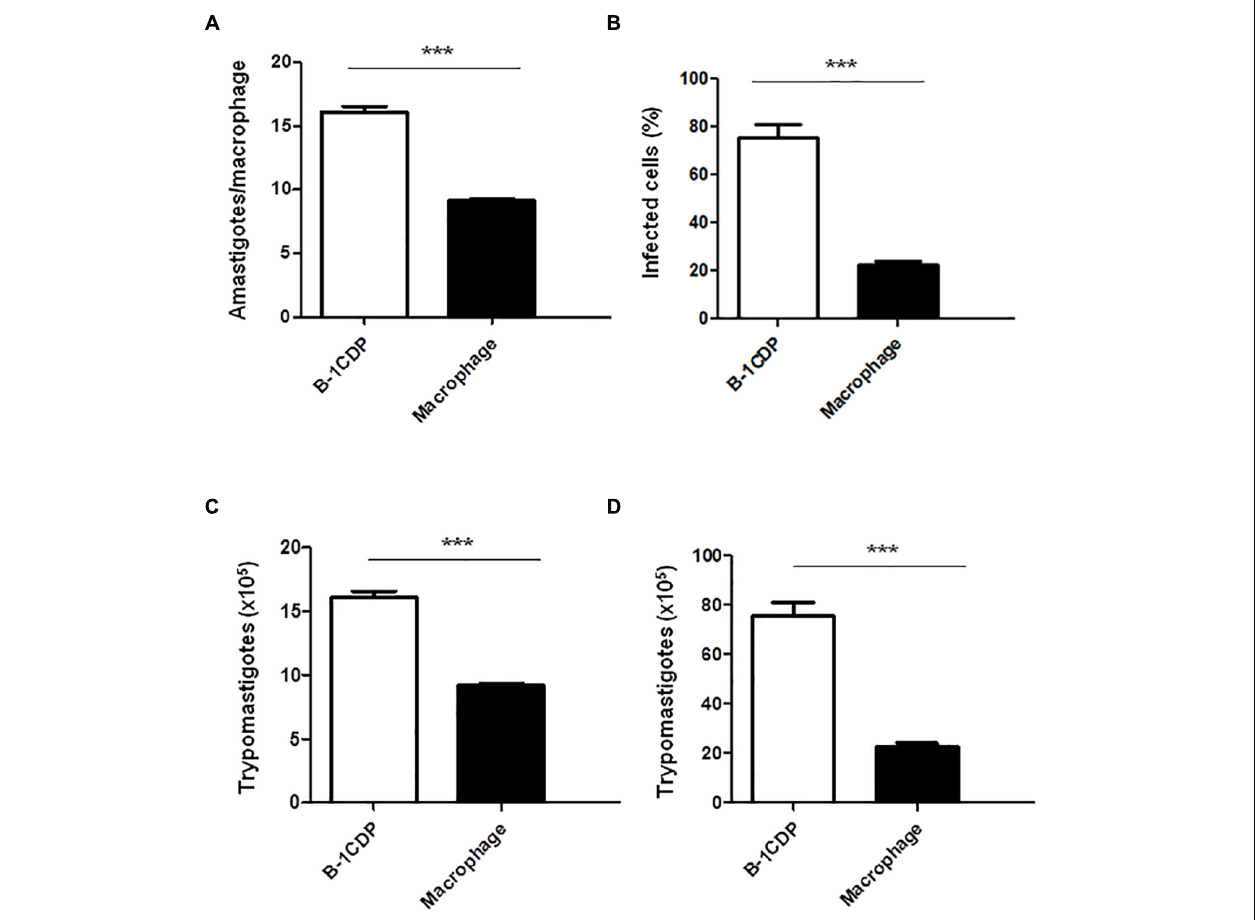
FIGURE 4 | Susceptibility of B-1CDP to Trypanosoma cruzi . B-1CDP (black bars) or peritoneal macrophages from BALB/c (white bars) were plated (2 × 10 5 /mL) and infected with trypomastigotes forms of T. cruzi Dm28c clone at a 5:1 parasite-to-cell ratios in 1 mL of DMEM 10% FCS and incubated at 37 ◦ C in 5% CO 2 . After overnight incubation, the cell culture was washed and incubated with DMEM 10% FCS and at 37 ◦ C in 5% CO 2 . After 3 days, cells were stained and amastigotes inside the macrophages were counted under light microscope (A) and set the percentage of infected cells (B) . To quantify trypomastigotes forms in the supernatants, the cells were infected with trypomastigotes forms of T. cruzi Dm28c clone. After overnight incubation, the cell culture was washed and incubated with DMEM 10% FCS and at 37 ◦ C in 5% CO 2 for 7 days (C) and 9 days (D) . All cultures were performed in triplicate and bars show the mean + SD. Statistical analysis was performed by t -test from representative results of three similar experiment ( ∗∗∗ p <